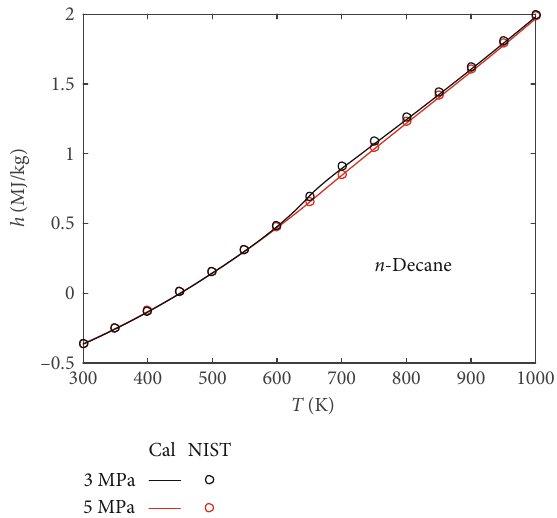
Figure 5: Comparison of enthalpies of n -decane under di ff erent pressures.